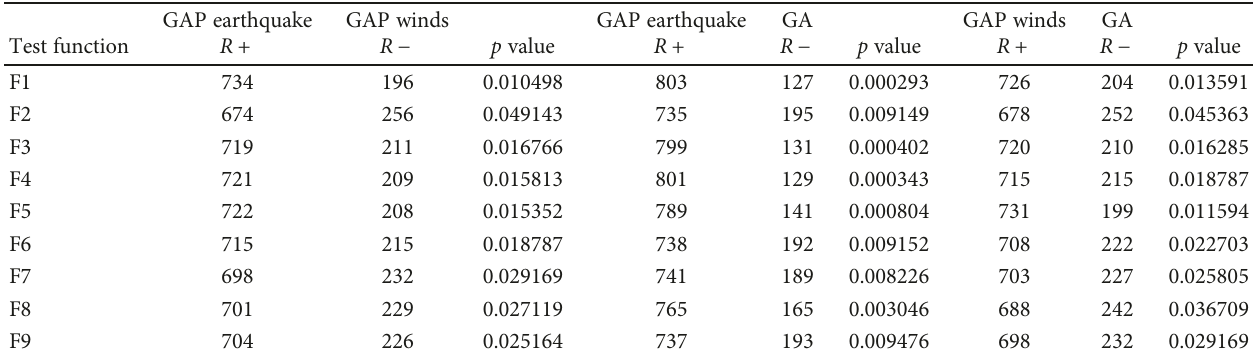
Table 2: Wilcoxon signed-rank test results. GAP earthquake shows an improvement over GAP winds with a level of signi fi cance alpha =0.05 and over GA with alpha =0.01. GAP winds show an improvement over GA with a level of signi fi cance alpha